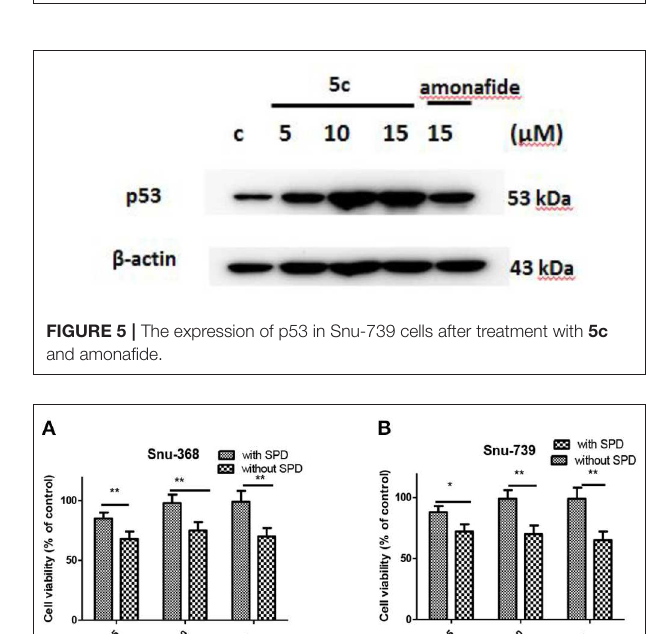
FIGURE 4 | The apoptotic percentage in Snu-739 cells was detected by FCM with (C) or without (A) 5c (10 µ M) or amonafide (B) (10 µ M) for 24h.